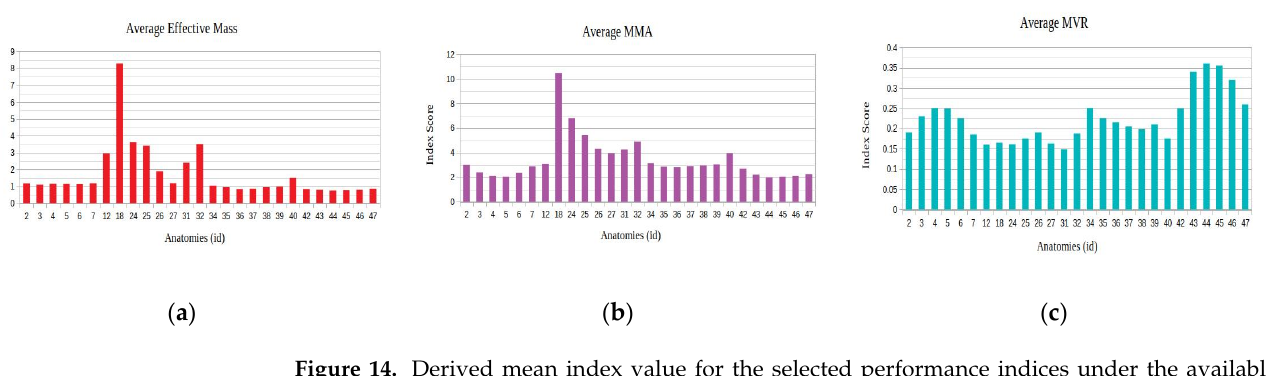
Figure 14. Derived mean index value for the selected performance indices under the available met- amorphic structure anatomies, for Task 2 (( a ) with respect to the Average Effective mass index, ( b ) with respect to the Average MMA index and ( c ) with respect to the average MVR index).